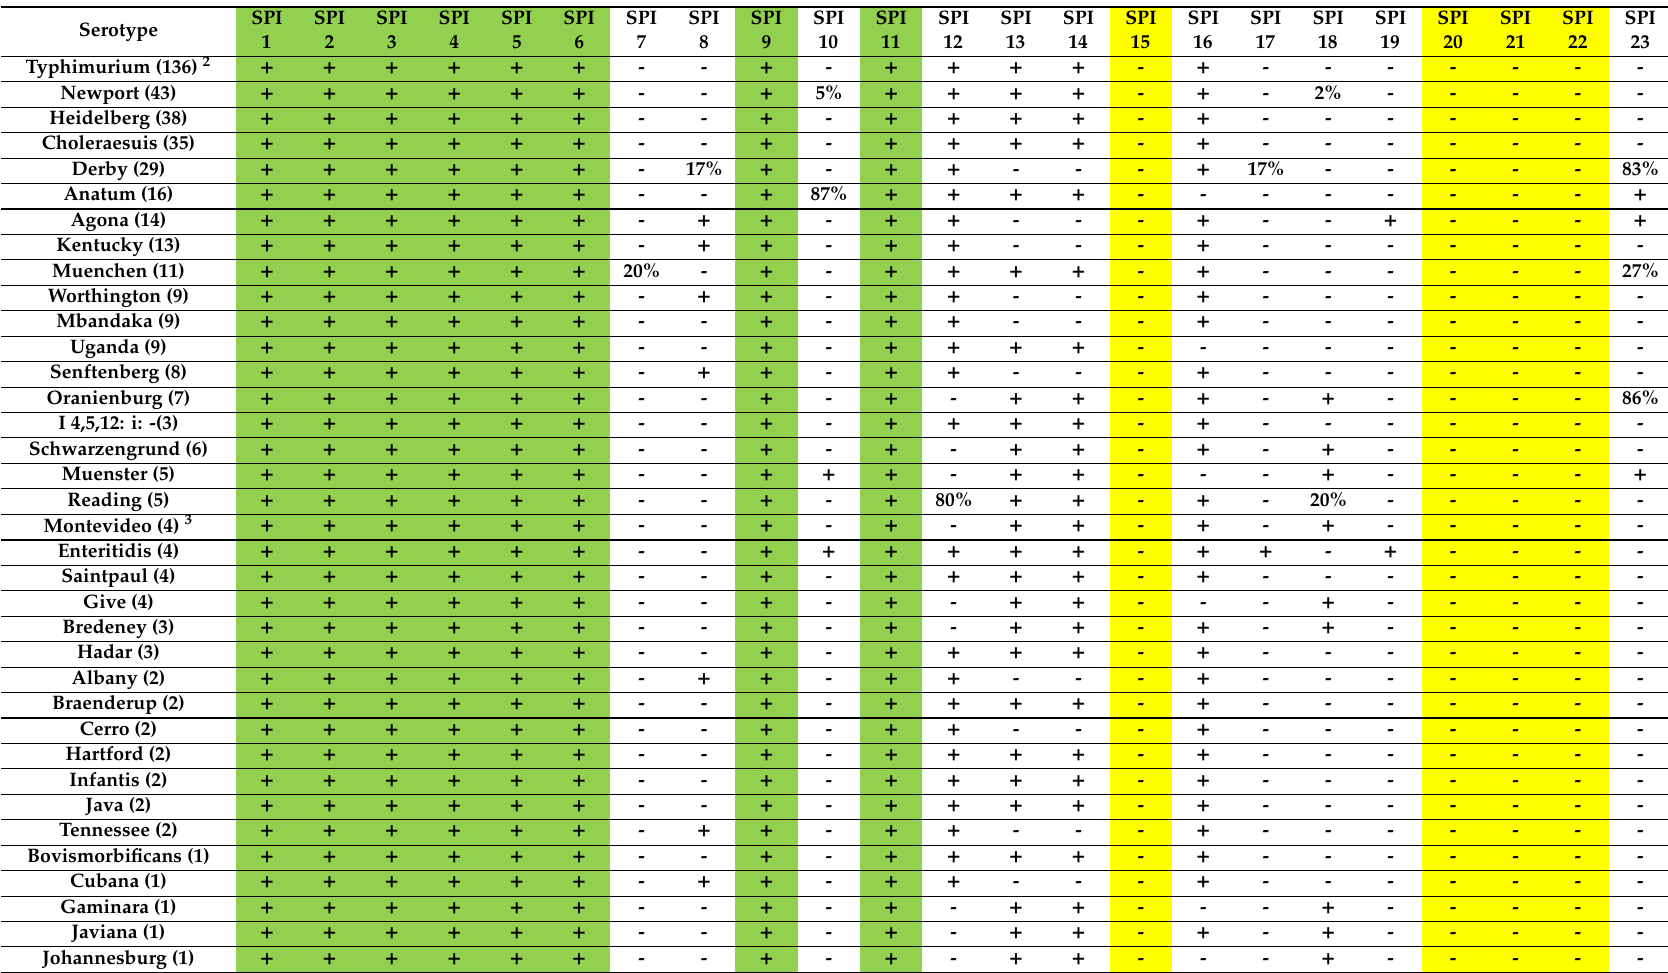
Table 1. Presence of Salmonella pathogenicity islands (SPI) in di ff erent Salmonella serotypes 1